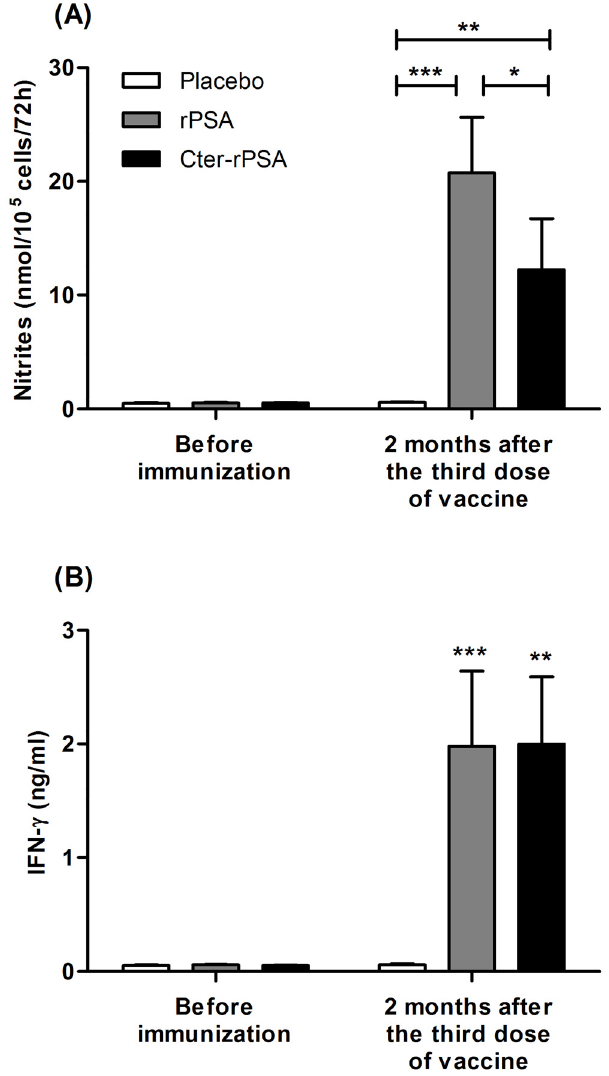
Fig 5. NO derivative and IFN- γ productions by 72 hours co-cultured canine macrophages from placebo and vaccinated groups of dogs (rPSA and Cter-rPSA). (A) NO 3- /NO 2- accumulation in the same samples was used as an indicator of NO production by activated macrophages and was assayed using the modified Griess reaction according to Pinelli et al . [64]. (B) IFN- γ levels were determined by a two-site sandwich ELISA in cell culture supernatants of 72 h co-cultured cells. Values represent means +/- standard deviation of triplicate experiments ( * p < 0.05, ** p < 0.01, *** p <